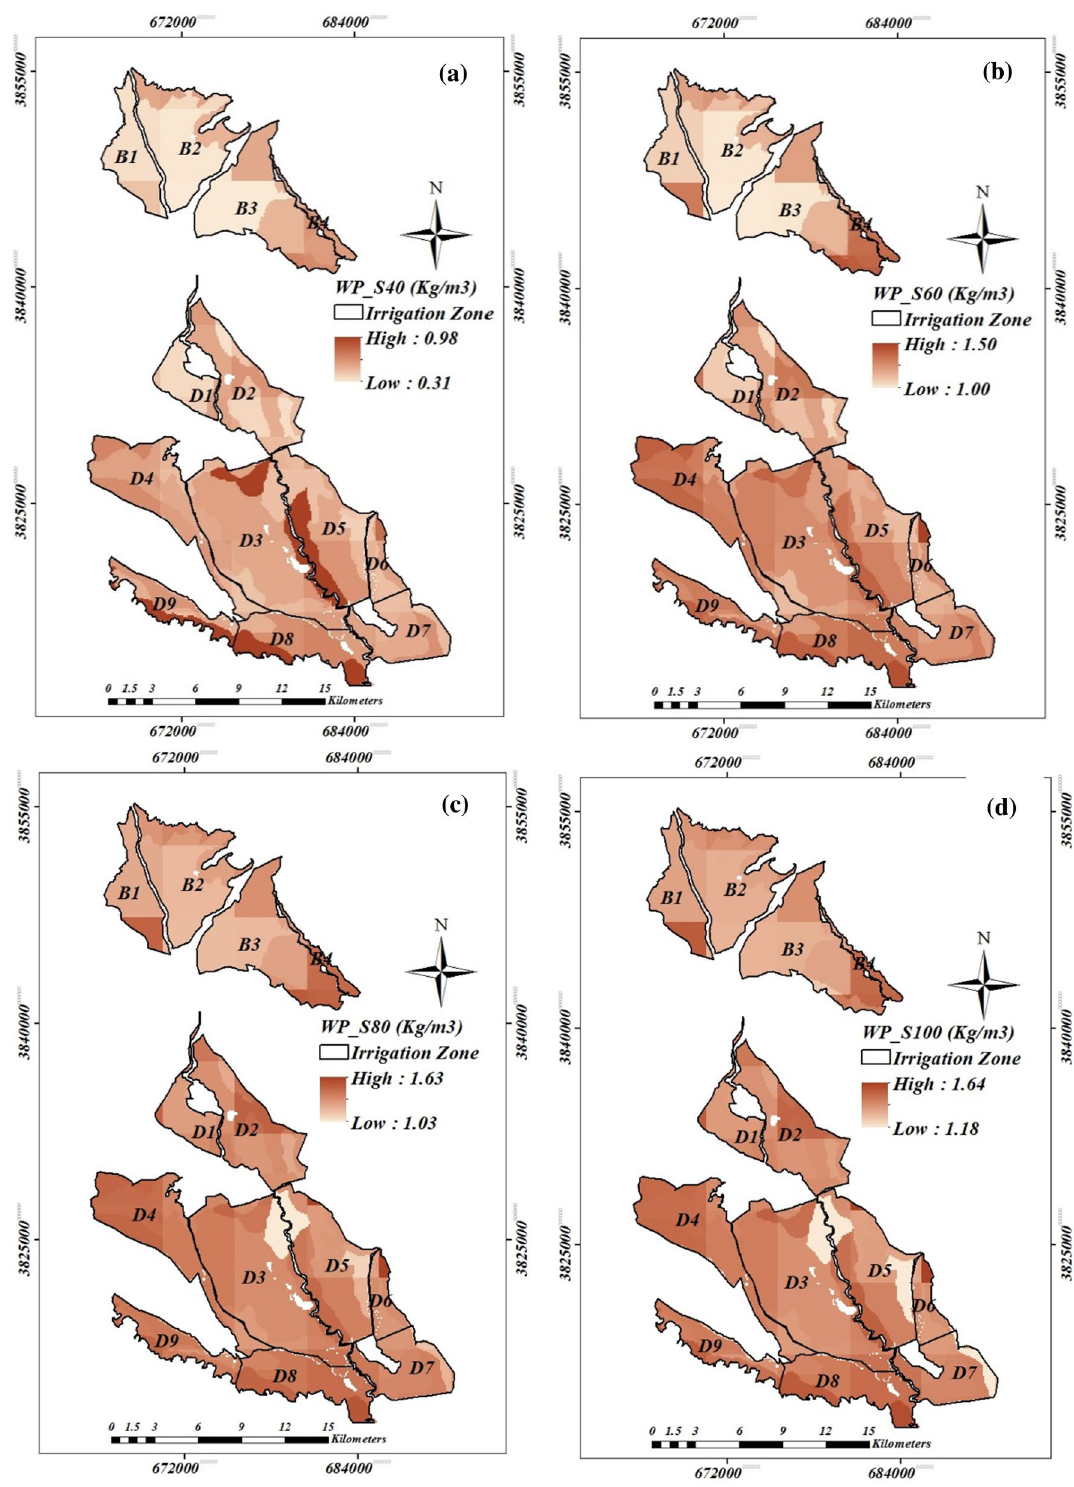
Fig. 8 Average spatial changes of water productivity for scenarios S40 ( a ), S60 ( b ), S80 ( c ), and S100 ( d